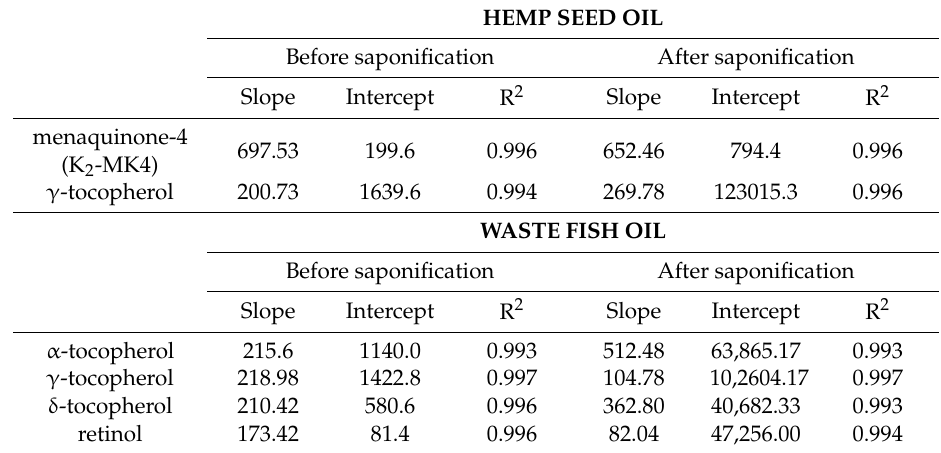
Table 1. Typical calibration data for the standard addition method for hemp seed oil and waste fish oil.